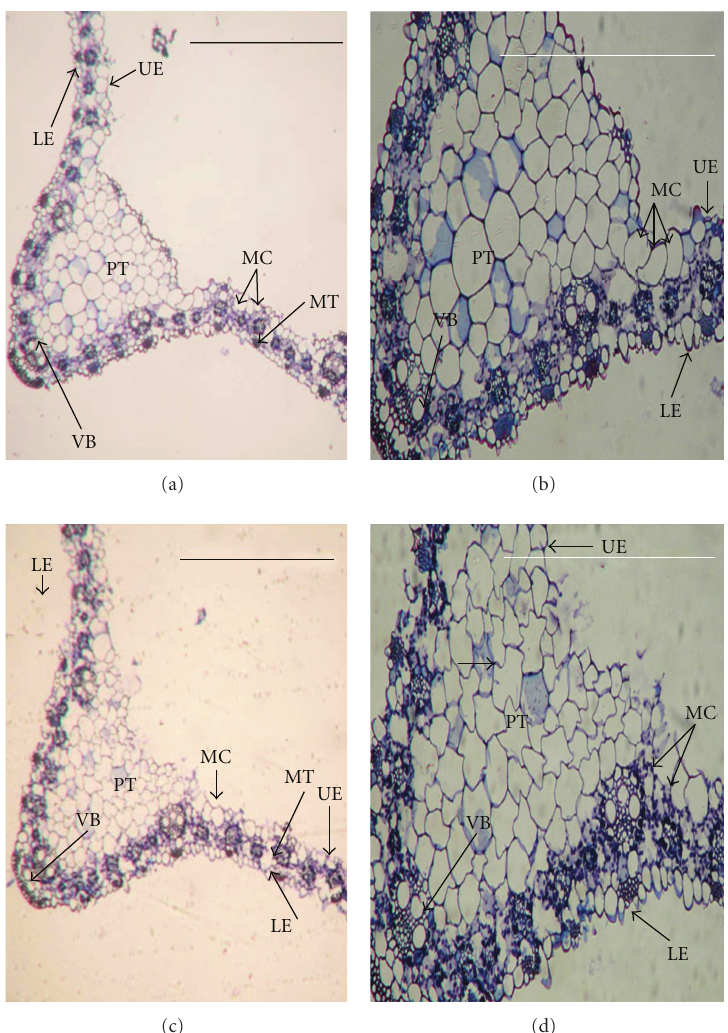
Figure 2: Cross sections through the lamina of untreated resistant (a, b) and treated resistant with fenoxaprop-p-ethyl biotypes (c, d) of E. crus-galli after 21